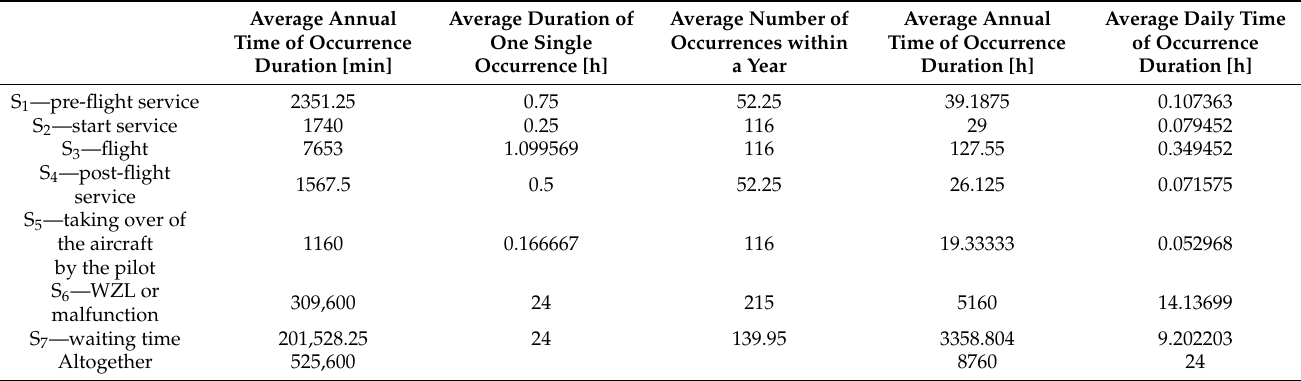
Table 2. Average annual time of all the analysed aircraft being in certain states (own